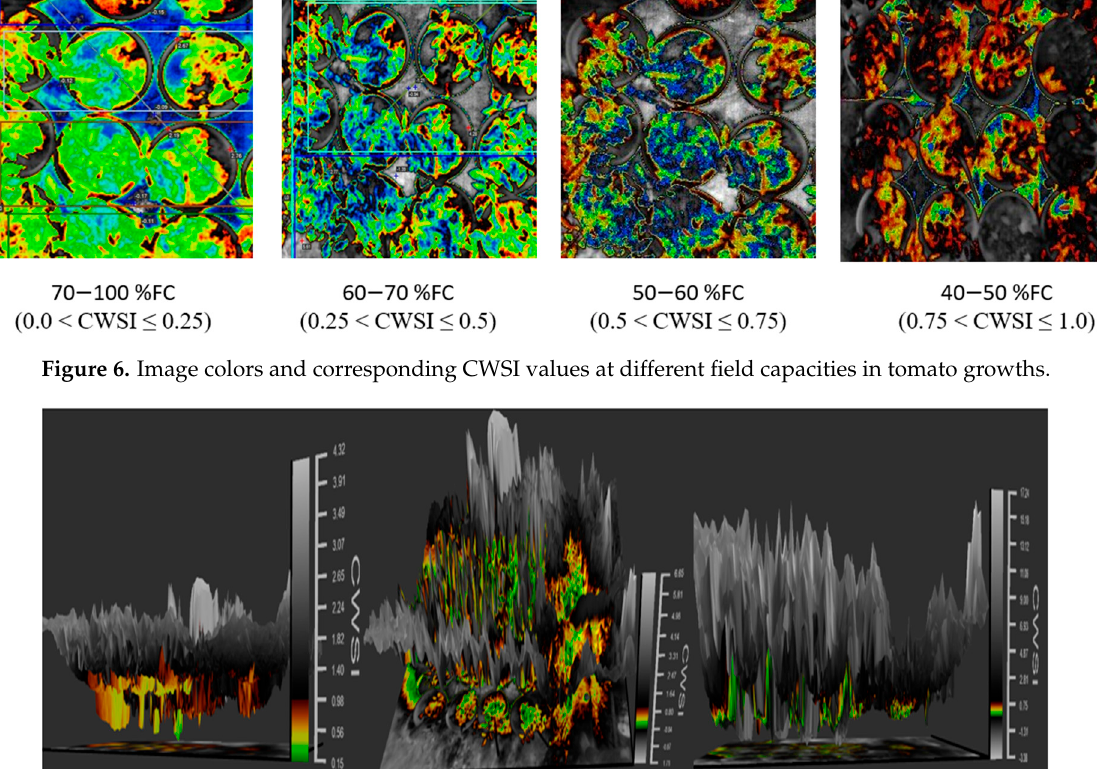
Figure 7. Three-dimensional panel displaying the thermal data in a 3D space of images on a tomato plant in different CWSI modes: ( a ) the differential mode, ( b ) empirical mode, and ( c ) theoretical mode, revealing water stress with color mapping in tomato plants.